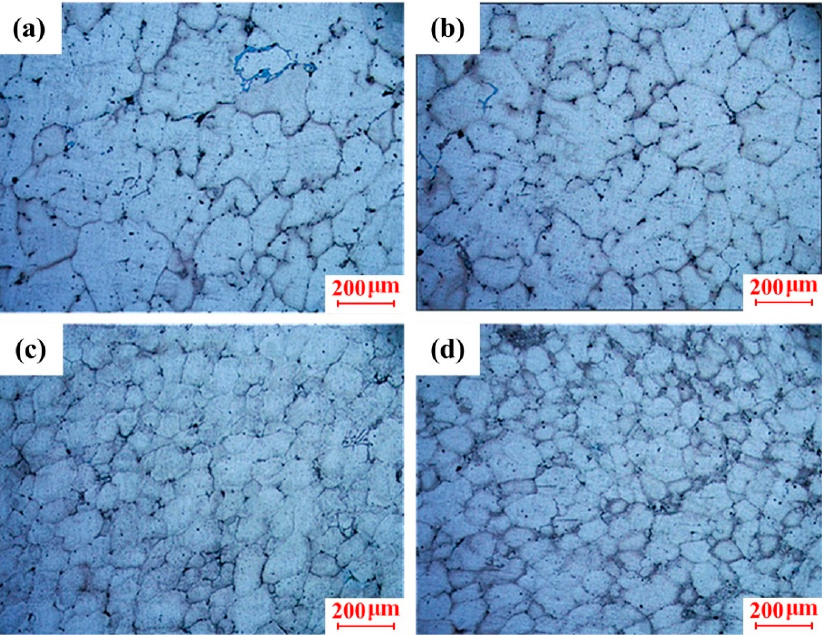
Figure 5. Microstructure of scroll under different holding temperature: ( a ) 645 °C, ( b ) 615 °C, ( c ) 600 °C, and ( d ) 595 °C.